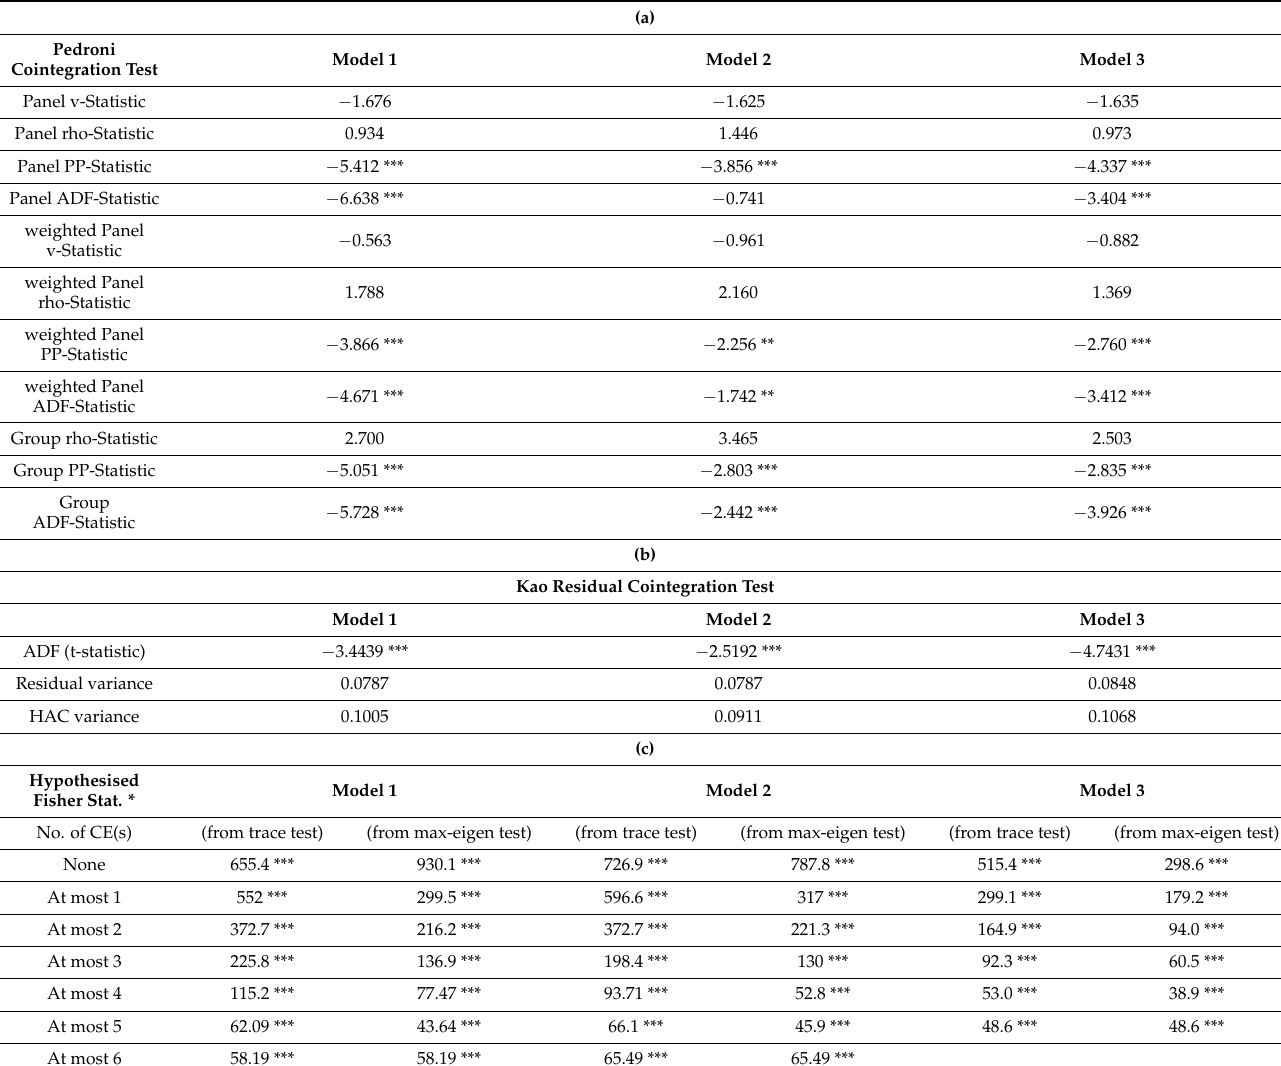
Table 5. (a) Pedroni residual cointegration test. (b) Kao residual cointegration test. (c) Johansen Fisher panel cointegration